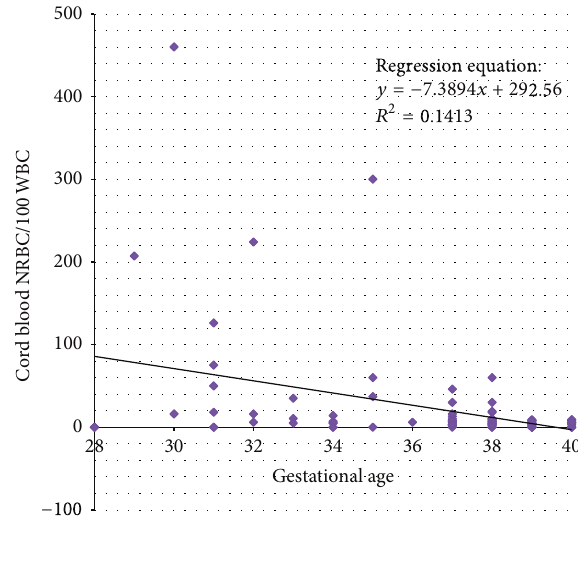
Figure 2: Effect of advancing gestational age on cord blood NRBC